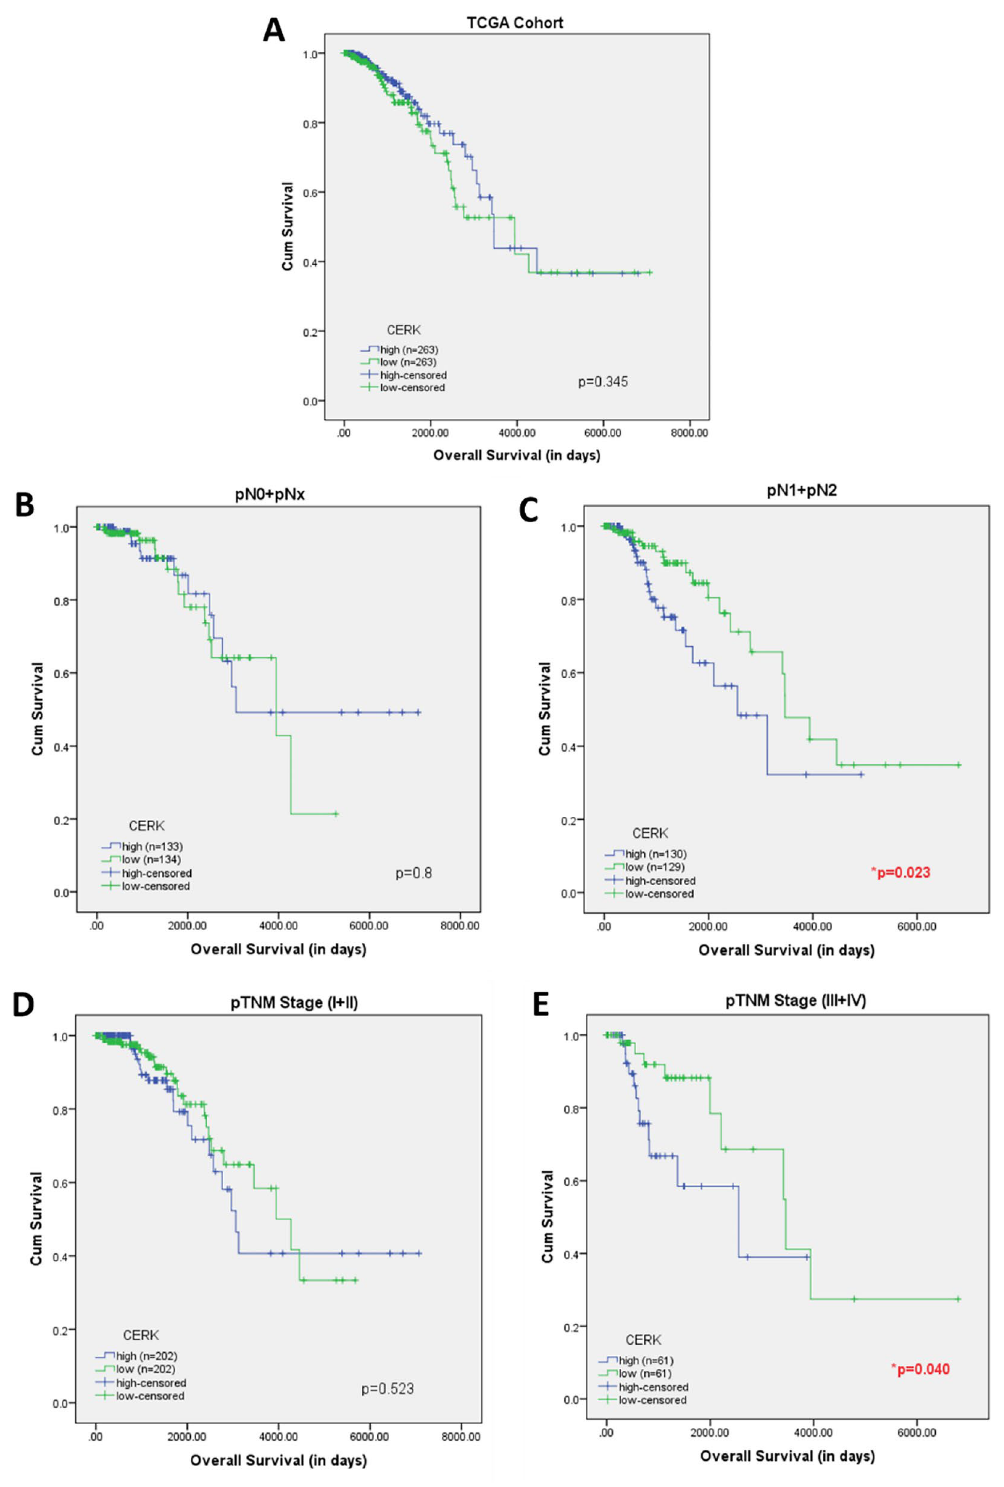
Figure 5. ( A ) Kaplan Meier survival curves showing OS in TCGA cohort stratified by CERK expression, ( B ) pN0 + pNx [Nodal Negative], ( C ) pN1 + pN2 [Nodal Positive], ( D ) pTNM (I + II)-[Early Stage], ( E ) pTNM (III + IV) [Late Stage]